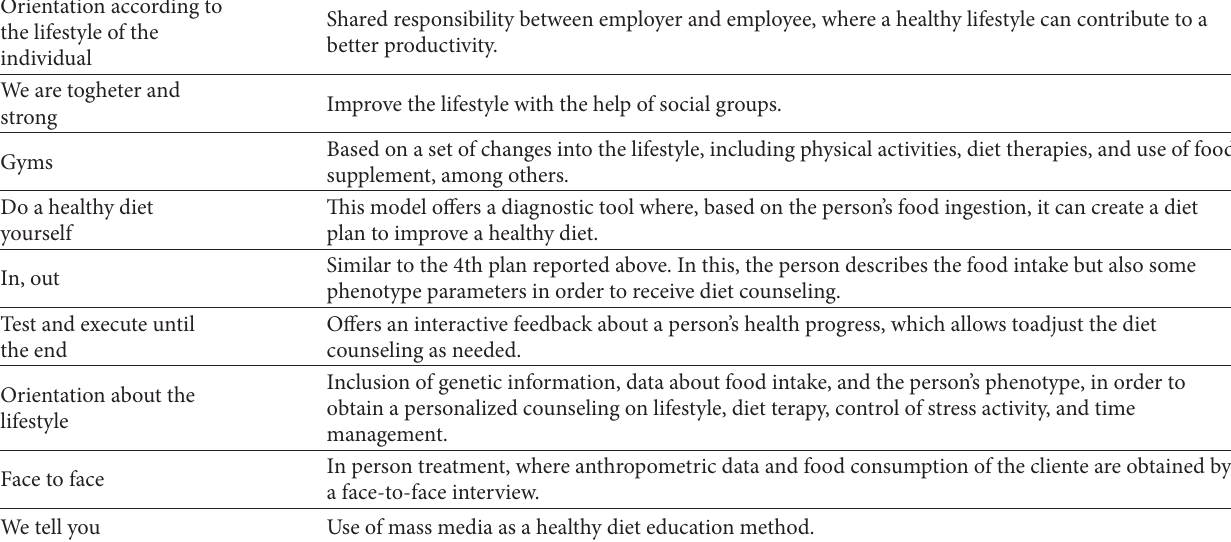
Table 1: Classification of Ronteltap and colleagues [15], showing the new marketing strategies into nine business